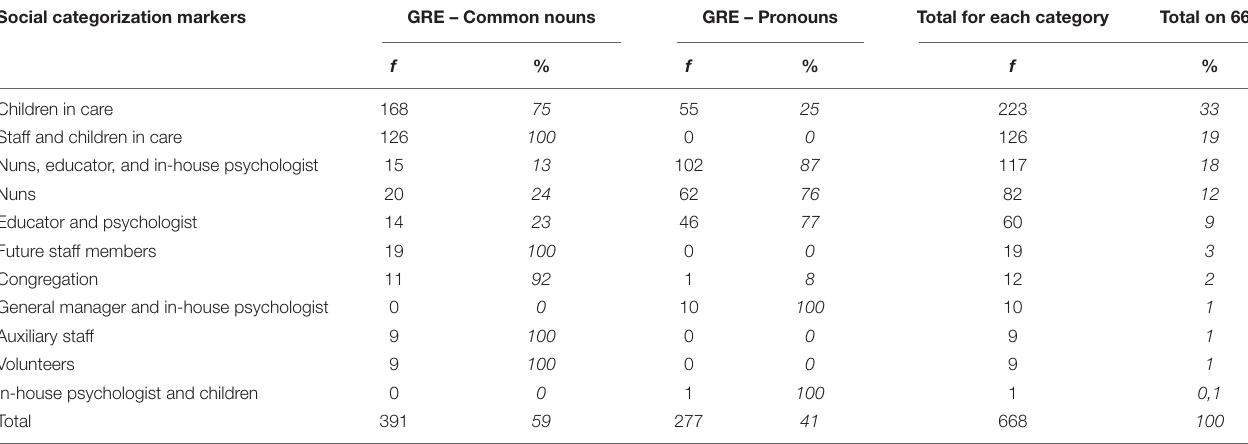
TABLE 1 | Frequency and percentage of internal stakeholder (ingroup) social categorization markers.